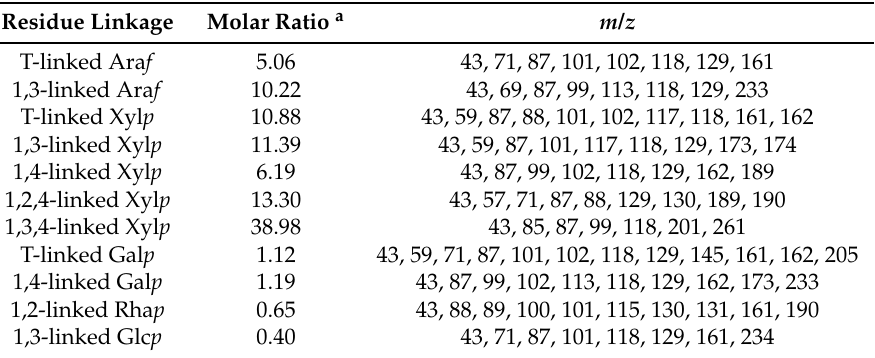
Table 2. Glycosyl-linkage compositions of